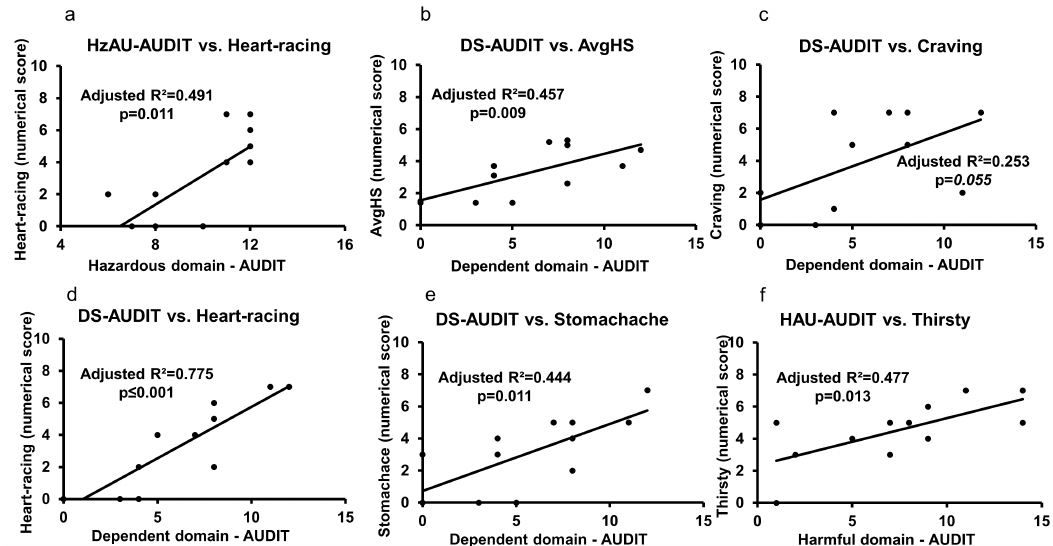
Figure 4. Association of AUDIT domains (Hazardous alcohol use (HzAU), dependence score (DS), and harmful alcohol use (HAU)) and individual hangover measures in heavy drinkers. ( a ) Association of HzAU and “Heart-racing” measure. ( b ) Association of DS and “Average hangover score” (AvgAHS) measure. ( c ) Association of DS and “Craving” measure. ( d ) Association of DS and “Heart-racing” measure. ( e ) Association of DS and “stomachache” measure. ( f ) Association of HAU and “Thirsty” measure. Statistical significance was set at p ≤